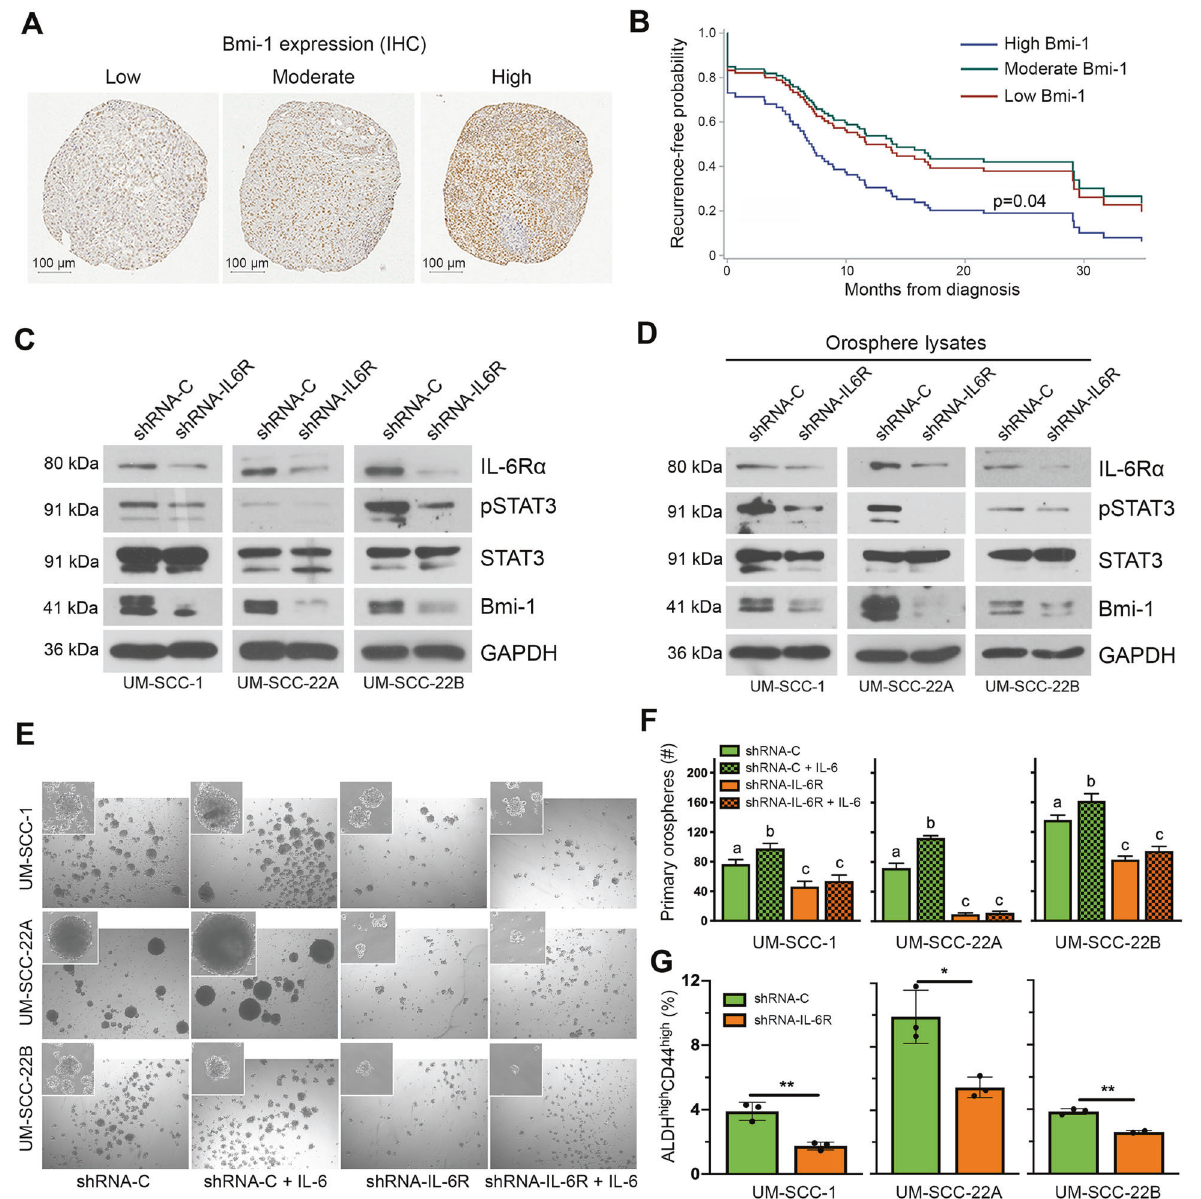
Fig. 1 IL-6/Bmi-1 signaling axis regulates cancer cell self-renewal and correlates with recurrence-free survival of HNSCC patients. A Immunohistochemistry staining for Bmi-1 in human HNSCC tumor cores of a tissue microarray. Representative images of staining patterns in Bmi-1-low, Bmi-1-moderate, and Bmi-1-high specimens. B Graph depicting adjusted recurrence-free survival function over time in tumors with Bmi-1 expression separated into intensity tertiles. C Western blottings showing baseline protein levels (IL-6R, phosphorylated STAT3, total STAT3, and Bmi-1) in HNSCC cells (UM-SCC-1, -22A, and -22B) stably transduced with lentiviral vectors expressing shRNA-IL-6R or scramble sequence control (shRNA-C). D Western blottings showing protein levels in lysates prepared from primary orospheres generated by HNSCC cells stably transduced with lentiviral vectors expressing shRNA-IL-6R or shRNA-C. E Representative images (×40) of primary orospheres (day 8) formed by IL-6R-silenced or vector control cells. Cells were treated with 20 ng/ml rhIL-6 the day after plating in ultra-low attachment (ULA) orosphere conditions. Inserts at ×100 magni fi cation. F Graph depicting the number of primary orospheres per well. Bar graphs display mean ± SD from fi ve fi elds per well in three wells per condition. G Flow cytometry graphs depicting the CSC fraction (ALDH high CD44 high cells) in IL- 6R knockdown and control cells. Bar graphs display mean ± SD ( n = 3). * p < 0.05 or ** p < 0.01 as determined by t -test. Different lowercase letters indicate statistical signi fi cance at p < 0.05. expression, even in the presence of excess rhIL-6 and/or impact of the IL-6 pathway on downstream signaling effectors Cisplatin (Fig. 3A, B). To determine the effect of Tocilizumab in in three HNSCC cell lines. Cells were exposed to Tocilizumab CSCs vs. bulk tumor cells, we sorted cells for ALDH/CD44 and and/or Cisplatin (Fig. 3A). In a parallel set of experiments, we performed western blot analyses. We observed that Cisplatin exposed cells to Cisplatin and/or Tocilizumab in the presence induces expression of Bmi-1 expression in sorted CSCs, of rhIL-6 (Fig. 3B). We observed that Cisplatin activated STAT3 and that Tocilizumab abrogates Cisplatin-induced Bmi-1 in and induced Bmi-1 expression (Fig. 3A). Tocilizumab inhibited CSCs (Fig. 3C). the expression of IL-6R and gp130, STAT3 activation, and Bmi-1 Cell Death and Disease (2021)